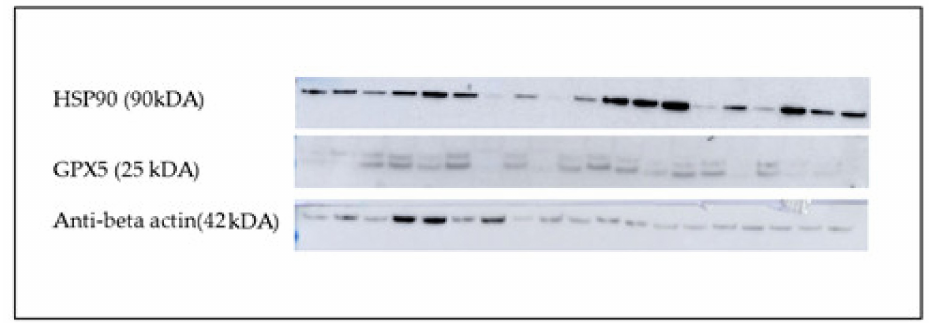
Figure 1. Indicative band patterns of spermatozoa HSP90 and GPX5. Actin was used as an internal